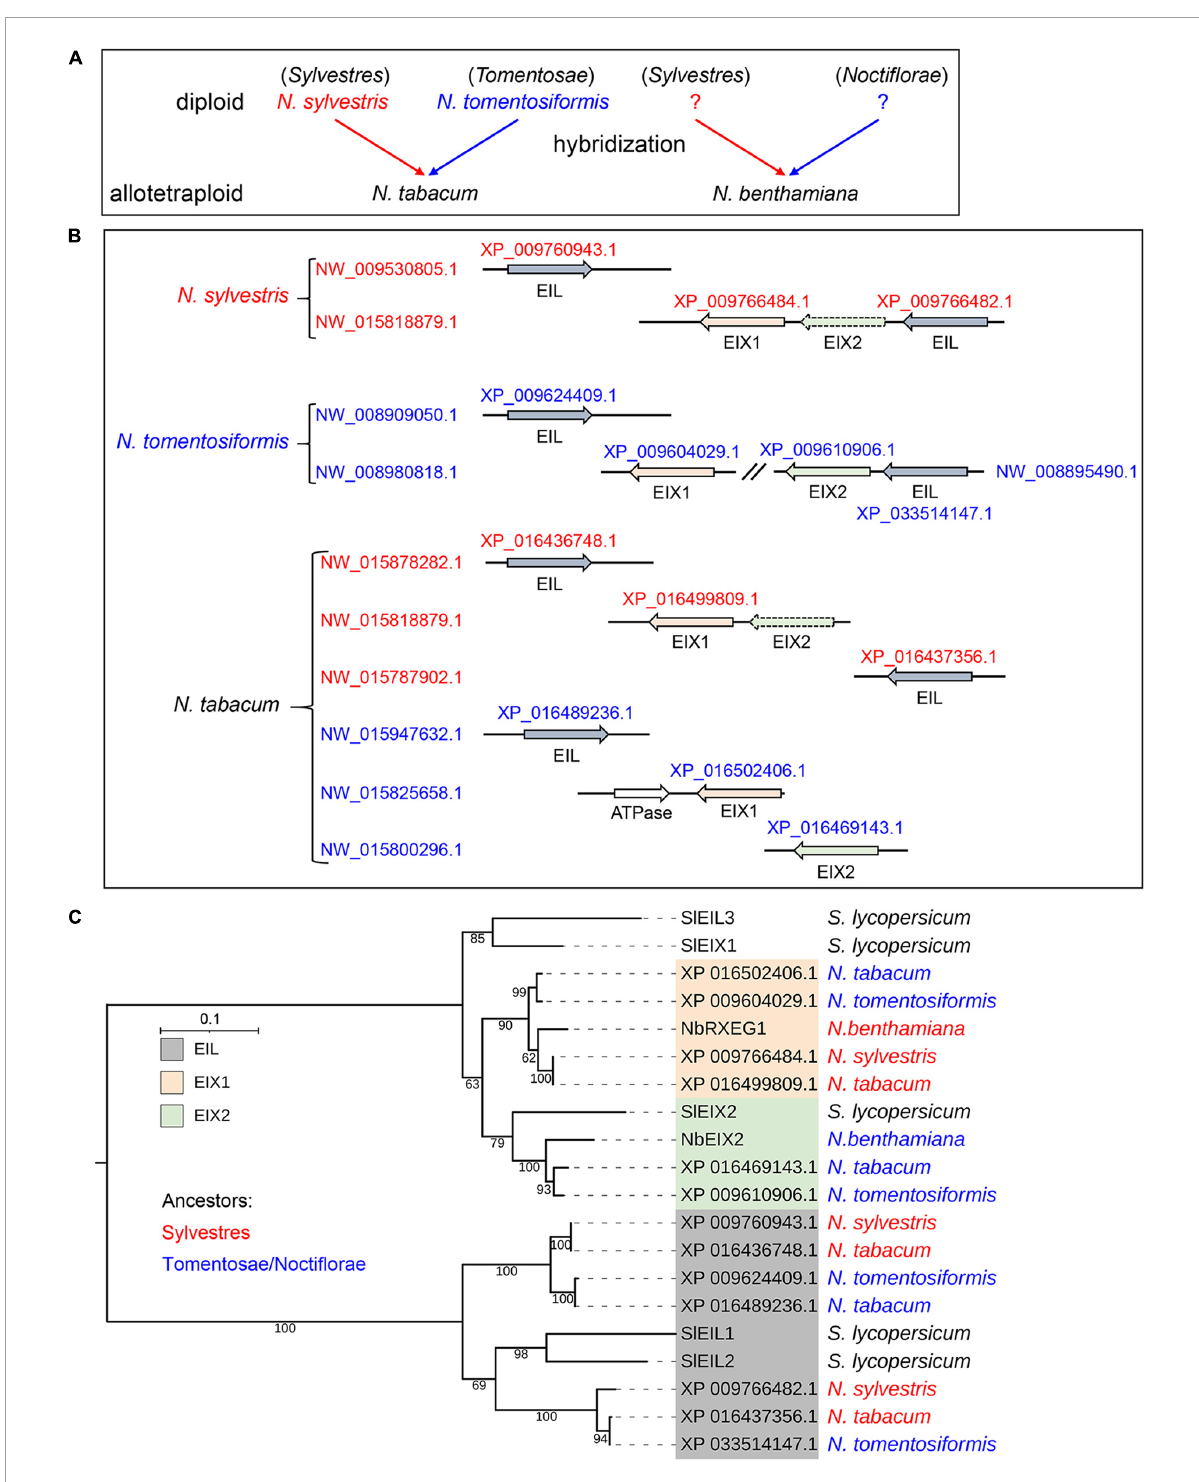
FIGURE6 The two divergent EIX-responding loci of Nicotiana benthamiana were acquired from different ancestors. (A) The allotetraploid N. tabacum and N. benthamiana are hybrids of diploid Nicotiana species. Different progenitors are marked in blue and red, respectively. (B) NbEIX2 homologs identified in N. sylvestris , N. tomentosiformis , and N. tabacum . Accession numbers of the proteins and scaffolds shown in the figure are obtained from the GenBank database. The dotted arrow indicates pseudogene. (C) Phylogenetic analysis of NbEIX2 homologs from selected Solanaceae plants. NbEIX2 homologs are divided into three clades: EIX1, EIX2, and EIL. Sequences from different ancestors are marked in blue and red, respectively. The maximum likelihood phylogenetic tree was generated by